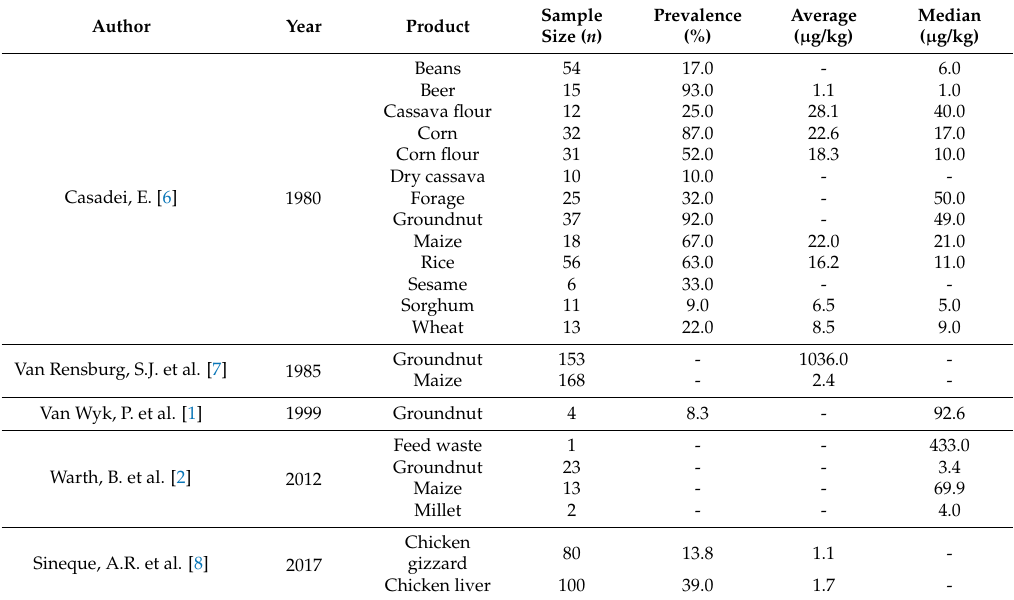
Table 1. Summary of the major aflatoxin studies in Mozambique and their